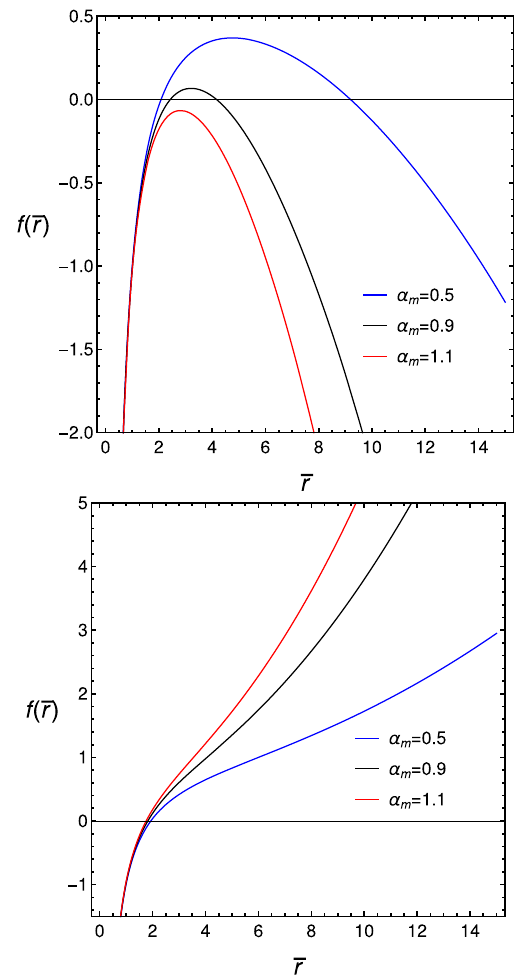
Fig. 1 The left panel shows the horizon structure of the de Sitter solu- tion for the value of α m as α m = 0 . 5 (blue line), α m = 0 . 9 (black line) and α m = 1 . 1 (red line). The right panel shows the horizon structure of the AdS solution for the value of α m as α m = 0 . 5 (blue line), α m = 0 . 9 (black line) and α m = 1 . 1 (red